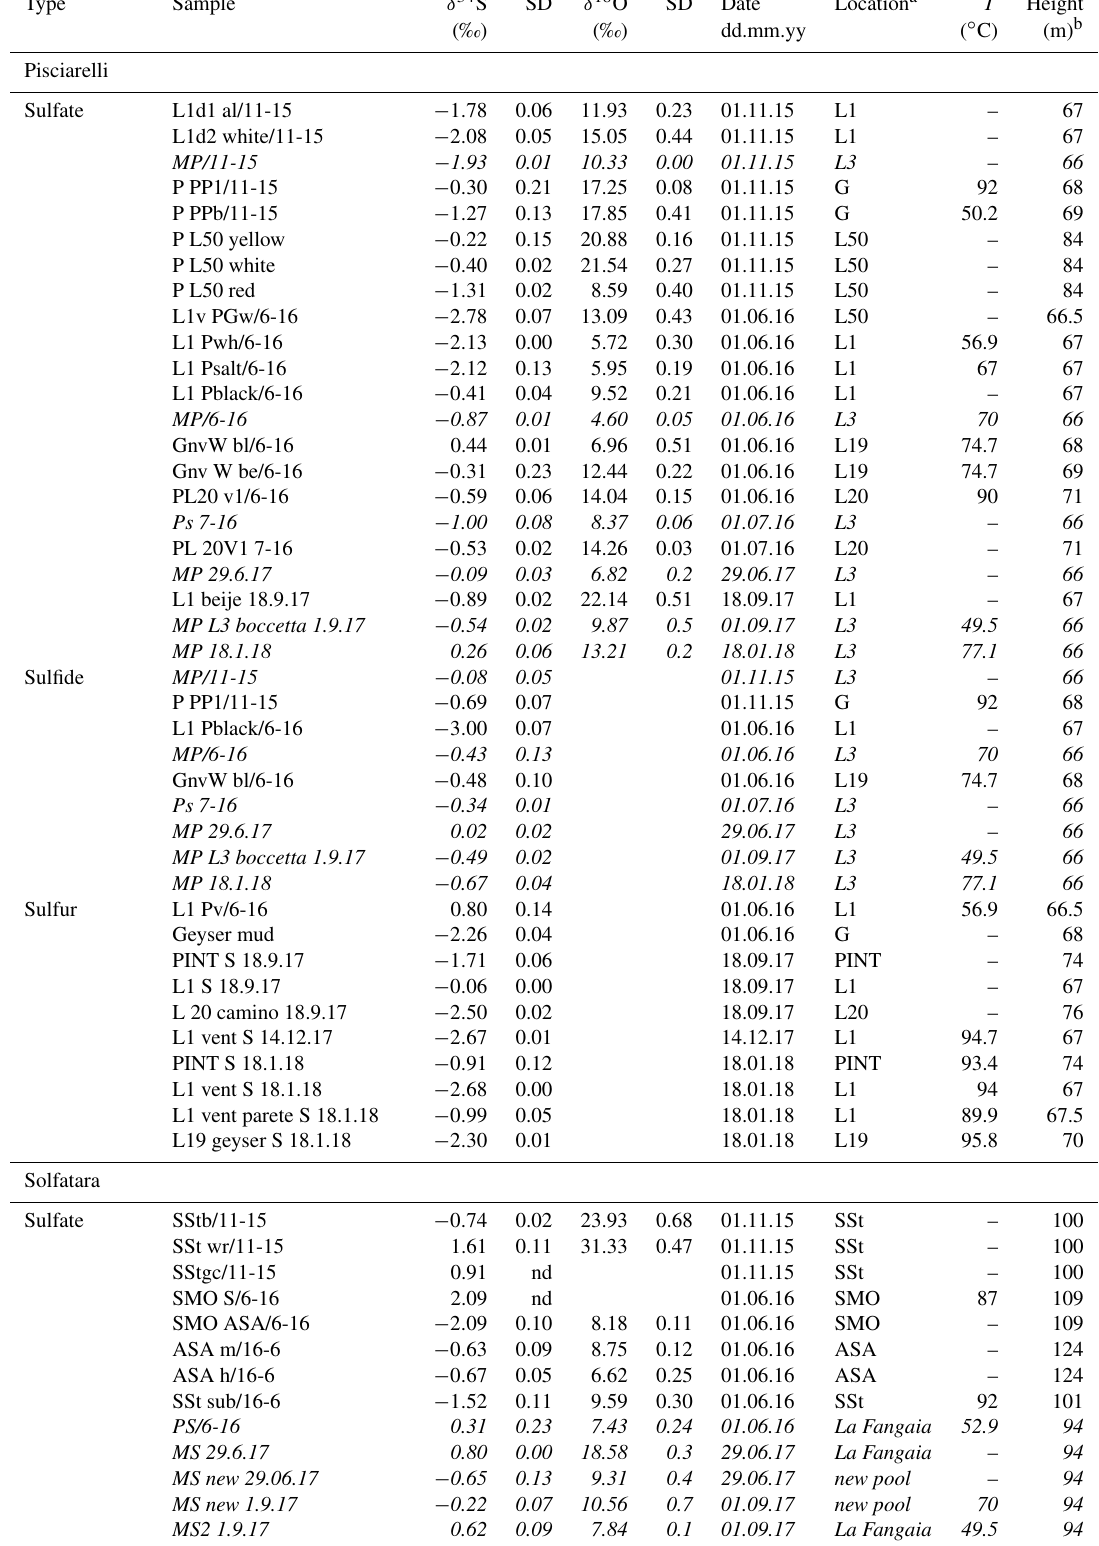
Table 2. δ 34 S vs. δ 18 O values of sulfur-bearing minerals. Sample name as in Tables 1 and S1; the muds are in italic.